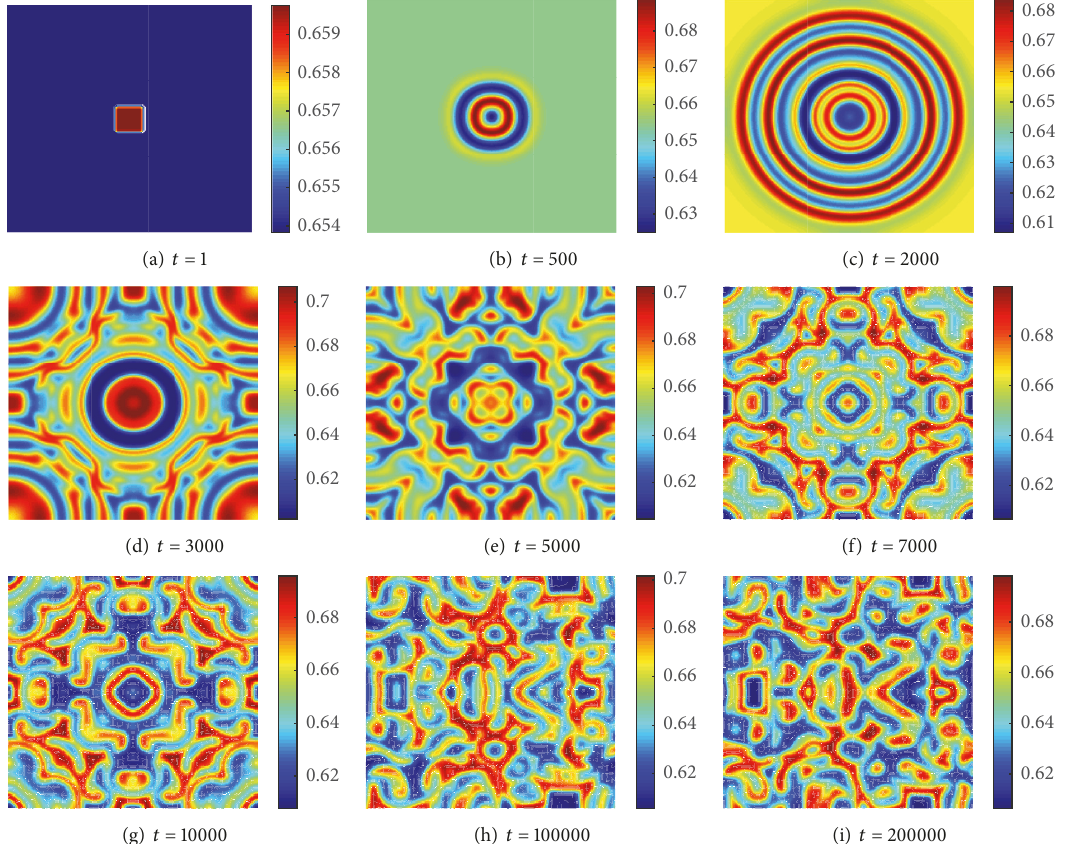
Figure 8: Pattern formation resulting from spatially symmetry breaking on invariant closed curves and starting with deterministic initial condition. 𝑎 = 1.63, 𝑏 = 0.1, 𝑐 = 0.32, 𝑑 = 0.22, 𝐷 1 = 0.6, 𝐷 2 = 1.2, 𝜏 = 5.1, 𝛿 = 10, and 𝑛 = 200.